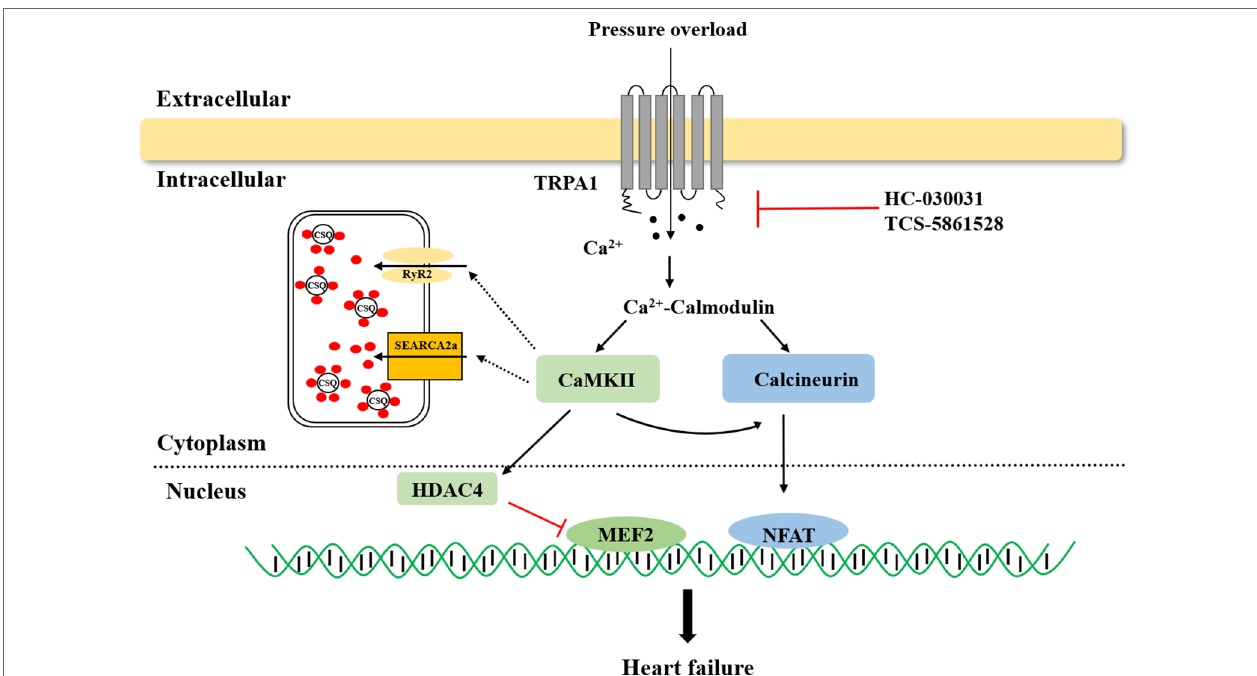
FIGURE 1 | The role of transient receptor potential ankyrin 1 (TRPA1) in heart failure. TRPA1 channel inhibition decreased Ca 2+ influx and inhibited Ca 2+ -dependent pathway activation, ultimately ameliorating pressure overload induced-heart failure. CaMKII, Ca 2+ /calmodulin-dependent protein kinase II; HDAC4, histone deacetylase 4; MEF2, myocyte enhancer factor 2; NFAT, nuclear factor of activated T